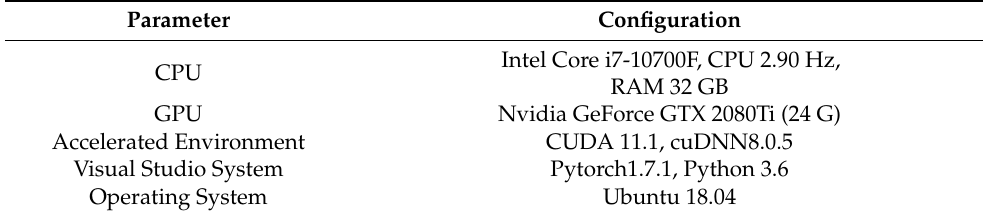
Table 3. Experimental environment configuration.